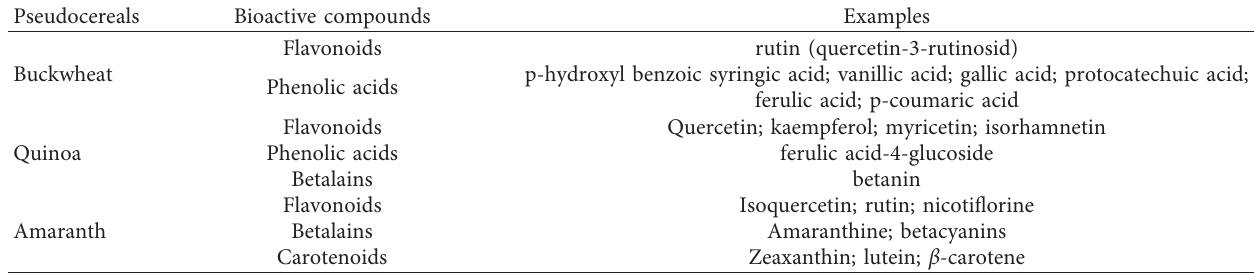
Table 2: Bioactive compounds present in amaranth, buckwheat, and quinoa (see Thakur et al. [56]). Pseudocereals Bioactive